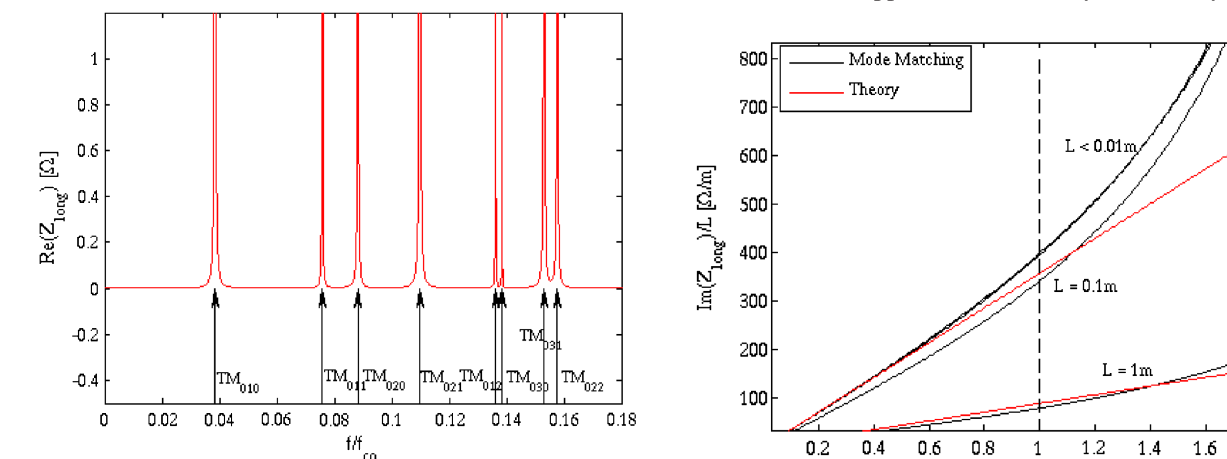
FIG. 9 (color online). Comparison between mode matching and theory for cavity impedance at low frequency. t ¼ 0 . 25 cm, b ¼ 5 cm, σ ¼ 0 S=m . P ¼ 5 , S ¼ 5 .